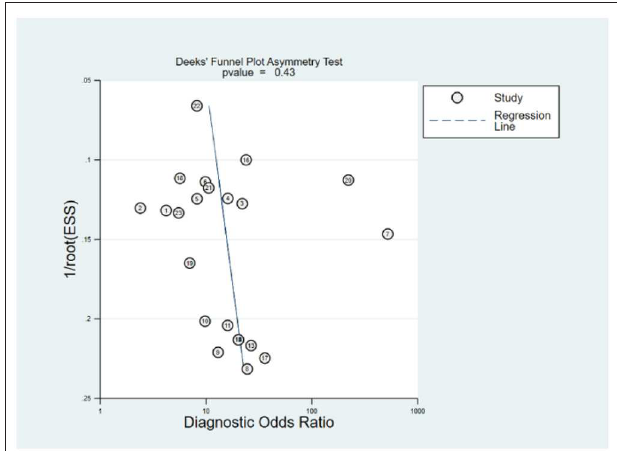
FIGURE 6 | Funnel plot for publication bias of circulating miRNA